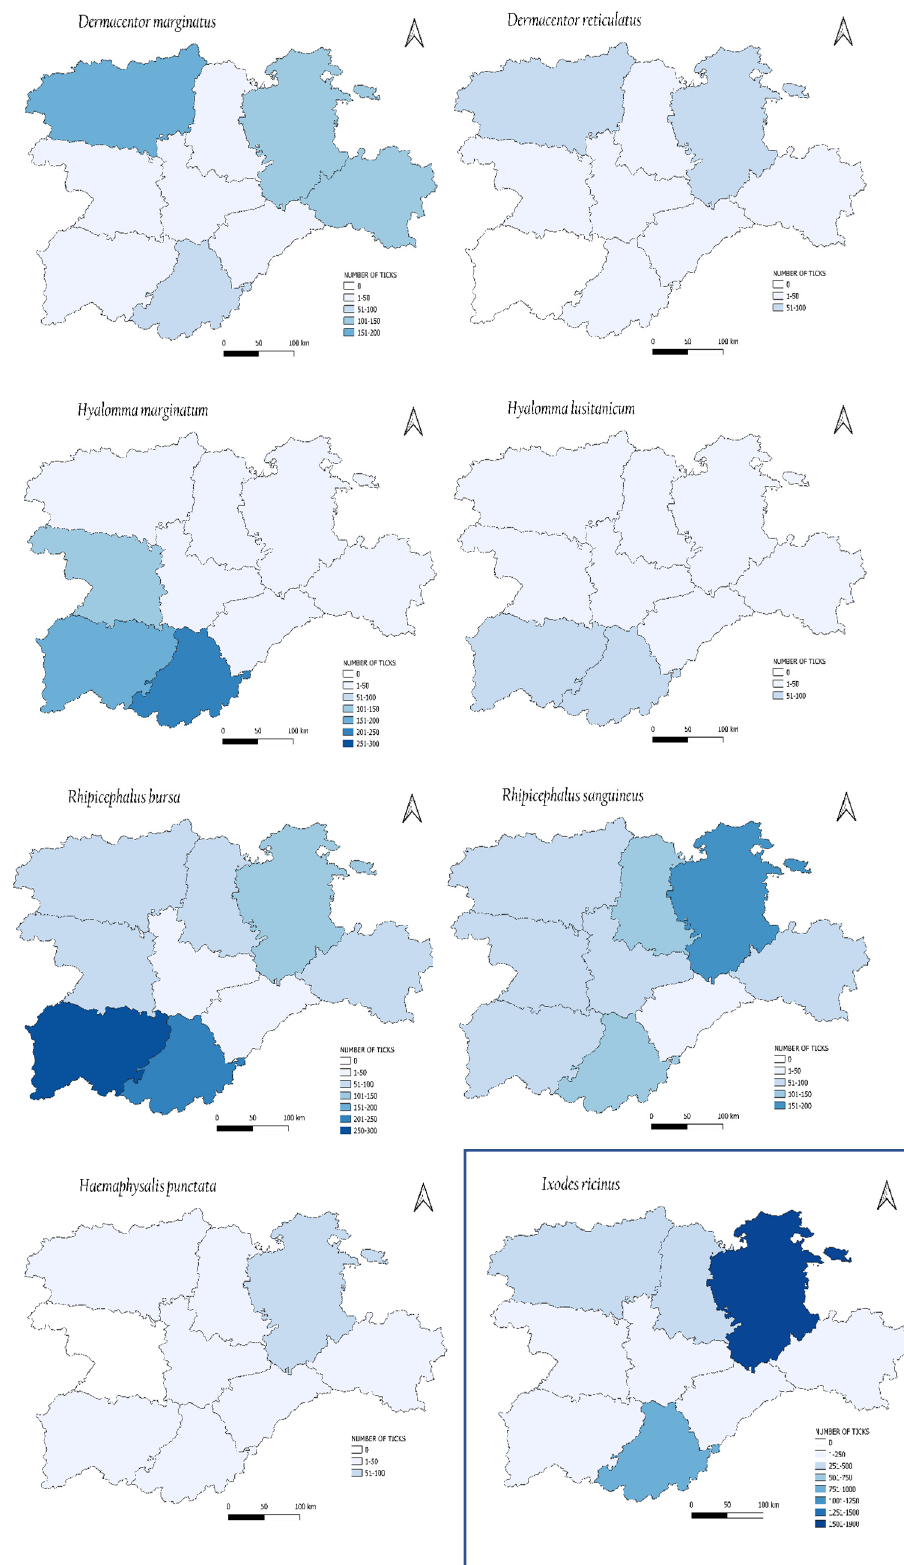
Figure 5. Geographical distribution of ticks. Source: QGIS 3.18.3 “Zürich” (Open Source Geospatial Foundation).